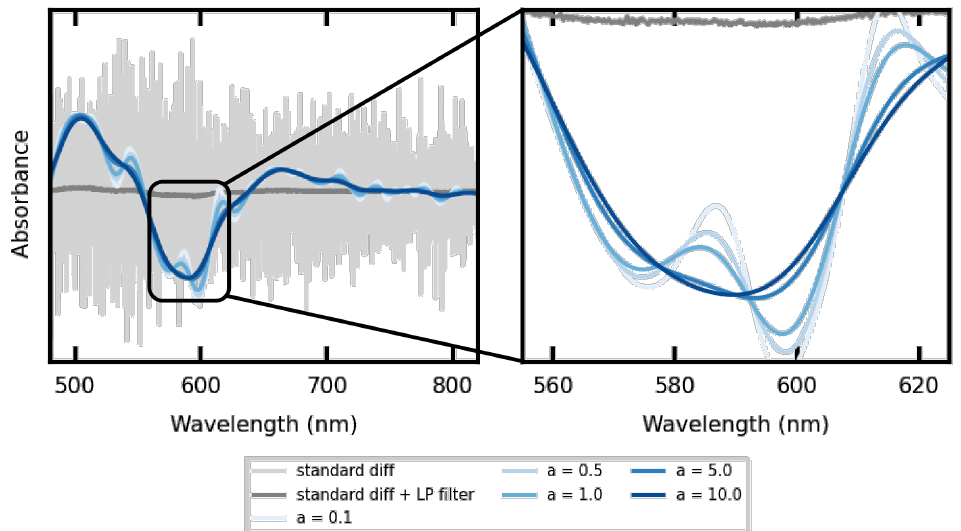
Figure A3. Impact of the regularization parameter (a) on the result of the second derivative of a measured LSPR band produced by gold nanospheres on a multi-mode optical fiber. A comparison with standard differentiation with and without filtering is also shown for